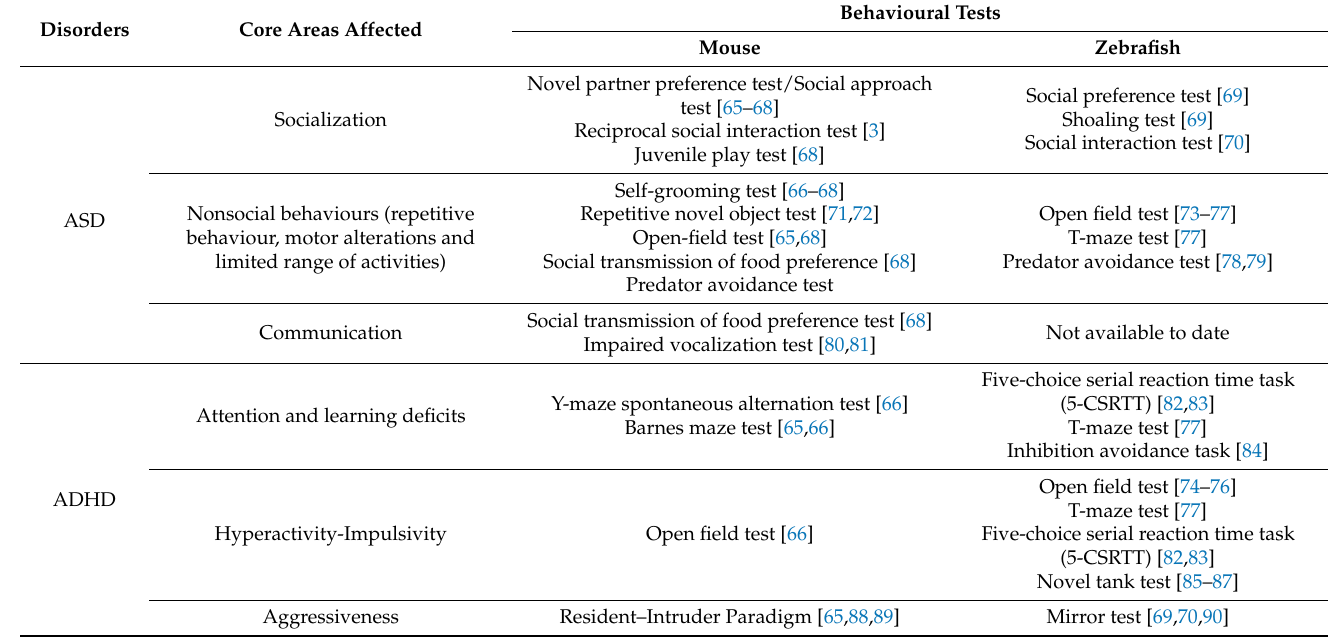
Table 5. Behavioural tasks to investigate ASD or ADHD-like alterations in mice and zebrafish. Summary of some behavioural tests in mice and zebrafish relevant to ASD and